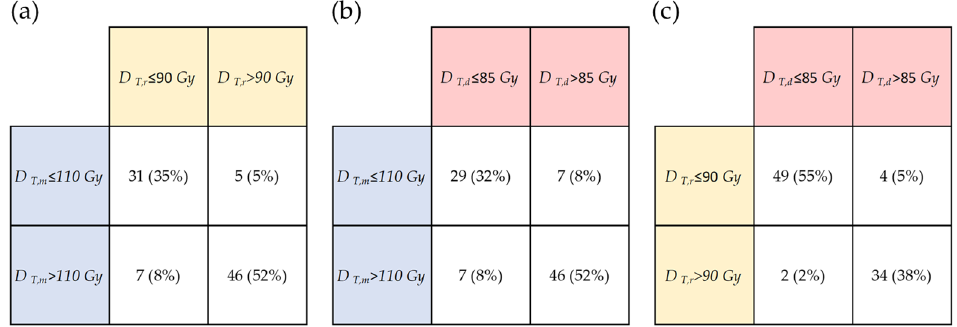
Figure 5. Confusion matrices for HCC/CCC patients for all the possible contouring comparisons: ( a ) manual and rigid; ( b ) manual and deformable; ( c ) rigid and deformable.